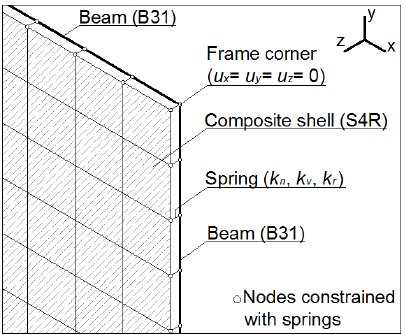
Figure 6. Modeling detail for the curtain wall with rigid brackets (M01 and M02